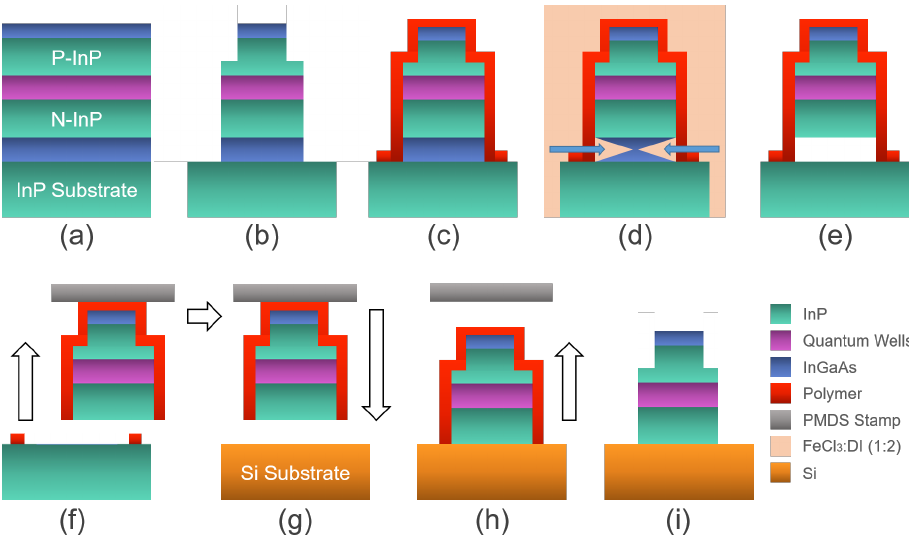
Figure 4. Devices are fabricated on an InP wafer including an InGaAs release layer at the bottom of the epitaxial structure ( a , b ). An anchor system made of polymer (resist) keeps the devices in place ( c ) during the undercut while allowing the etchant to penetrate underneath the mesas through some openings ( d , e ). Finally, the devices are picked up ( f ) and transfer-printed onto the new substrate using a Polydimethylsiloxane (PDMS) stamp ( g – i